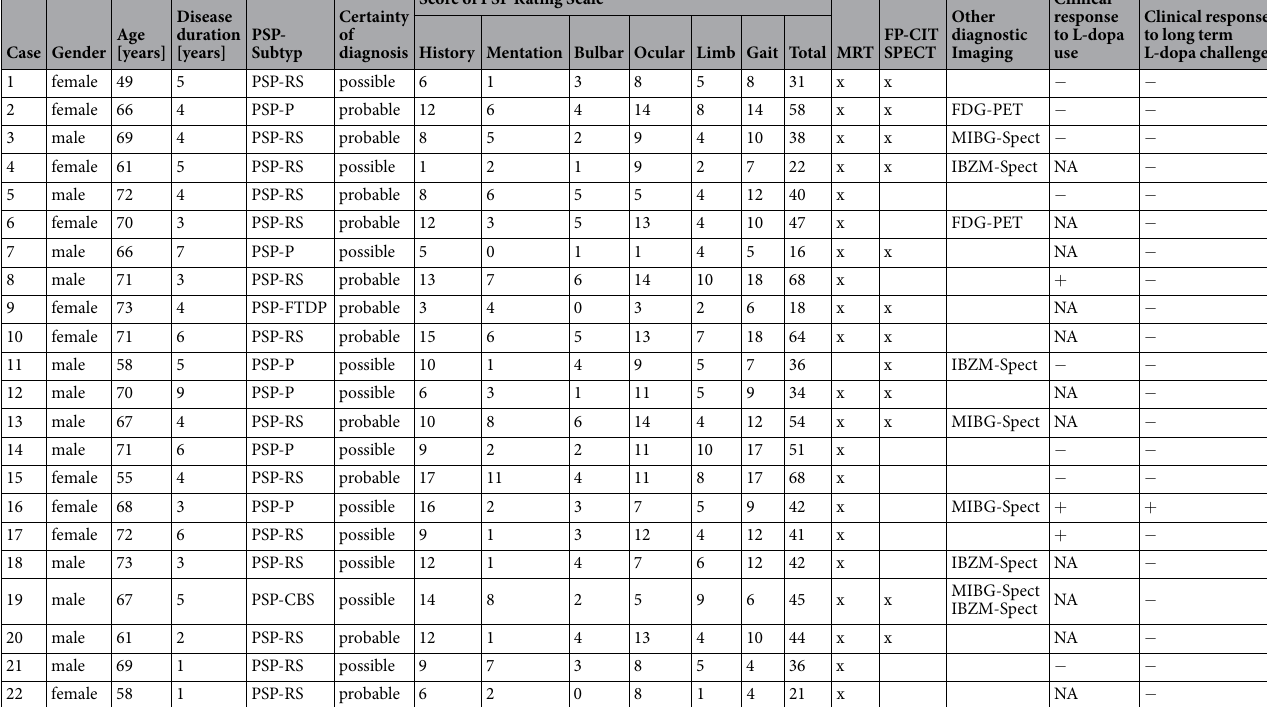
− Table 1. Characteristics of PSP patients (n = 22) including demographic and diagnostic data. “Disease duration [years]” was calculated from the date of the first diagnosis to the date of neurological assessment. The diagnosis of “clinically possible” or “clinically likely” PSP was made according to the clinical criteria for the diagnosis of progressive supranuclear palsy National Institute for Neurological Disorders and Society for PSP (NINDS- SPSP). PSP-RS: Richardson subtype of PSP, PSP-P: Parkinson subtype of PSP, PSP-FTDP: behavioral variant of PSP, PSP-CBS: Overlap syndrome of PSP with cortico-basal syndrome. Cases with application of MRI or FP-CIT-SPECT are labeled with “x”. Short term effect of L-dopa challenge was labeled with “ + ” in case of a positive responsev ≥ 30% on the UPDRS III scale and “ − ’’ in case of a response less than 30%. Long term effect of L-dopa use (duration more than 4 weeks) was labeled with “ + ” if patients and physician had the impression of at least some clinical relevant effect, otherwise response was labeled with “ − ”. NA = not